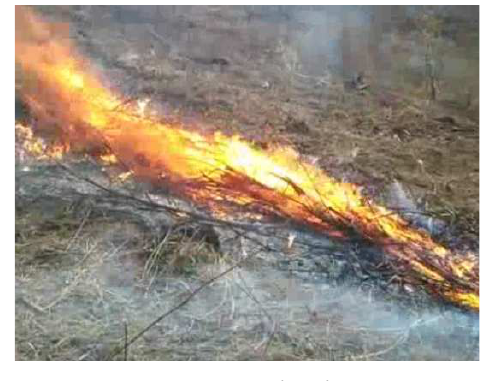
Figure 16. Surface fire.